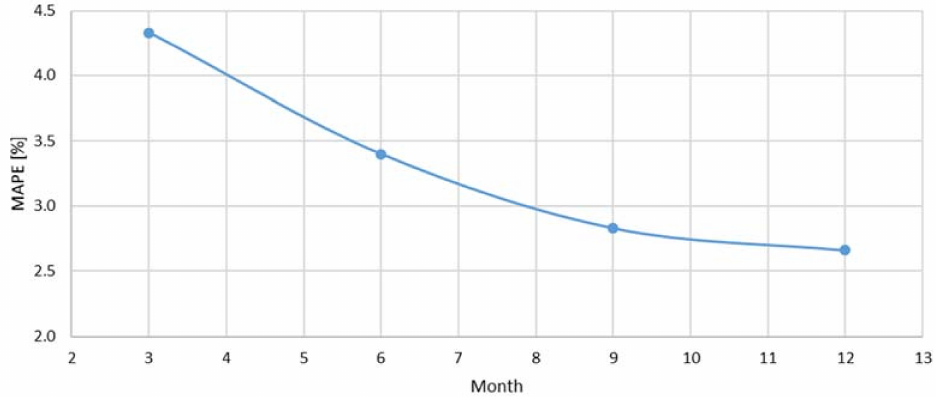
Figure 6. Impact of the learning set size on model quality. Three types of temperatures were used separately to perform the calculations: 24-h average temperature, maximum and minimum temperature, or temperature at